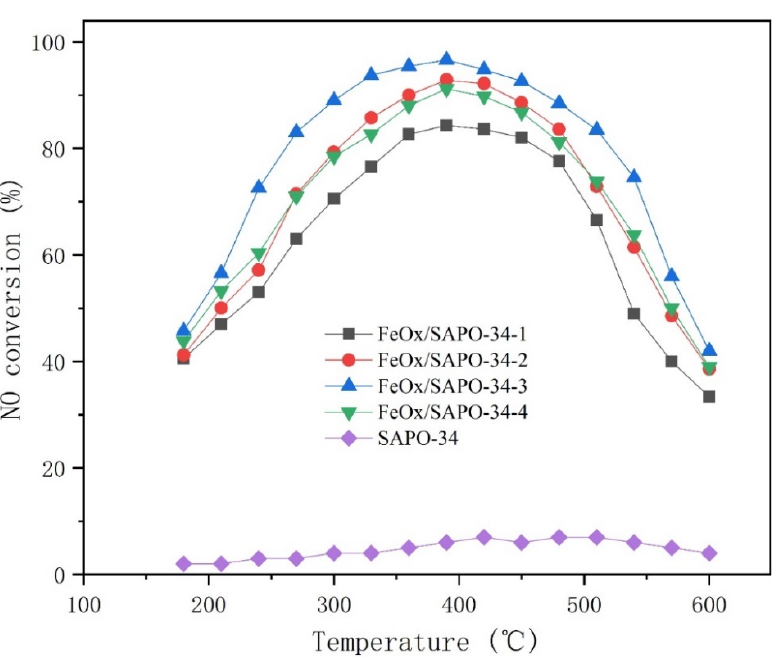
Figure 7. NO conversion of the different samples. Reaction conditions: 400 ppm NO, 400 ppm NH 3 , 6% O 2 and N 2 as balance, GHSV 30,000 h − 1 .